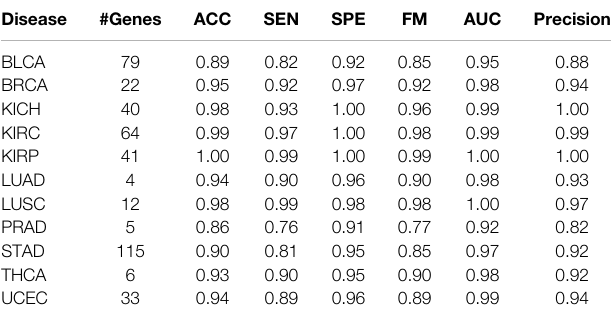
TABLE 5 | Performance results of miRModuleNet over the top-ranked group. Disease #Genes